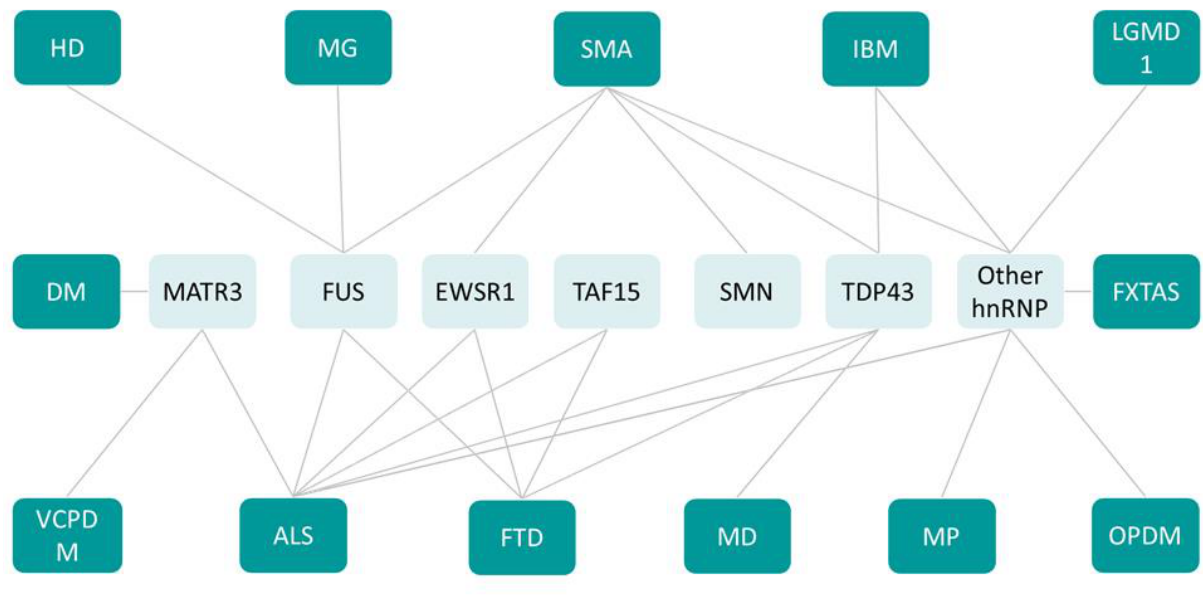
FIGURE 3: RBP with prion like domain network in neuromuscular disease. ALS: Amyotrophic lateral sclerosis, DM: Distal myopathy, FXTAS: Fragile X-associated tremor/ataxia syndrome, HD: Huntington disease, IBM: Inclusion body myopathy, LGMD1: limb-girdle muscular dystro- phy 1D, MD: Muscular dystrophy, MG: Myasthenia gravis, MP: Multisystem proteinopathy, OPMD: Oculopharyngeal muscular dystrophy, SMA: Spinal muscular atrophy, VCPDM: Vocal cord and pharyngeal weakness with distal